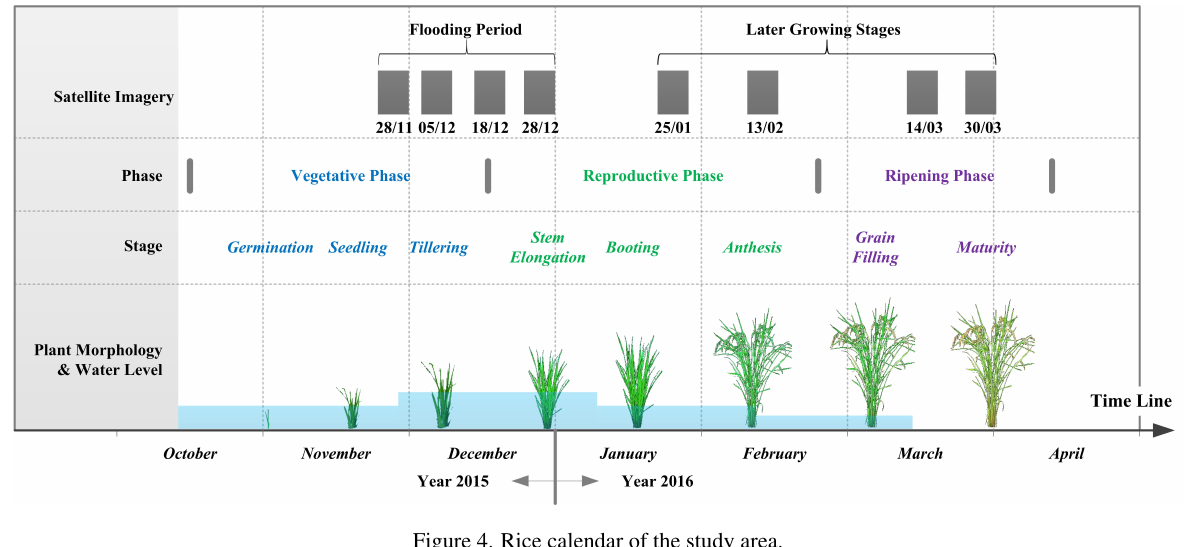
Figure 4. Rice calendar of the study area.